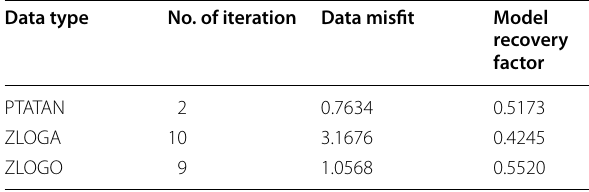
Table 1 Inversion performance for near‑surface heterogeneity model (Fig.